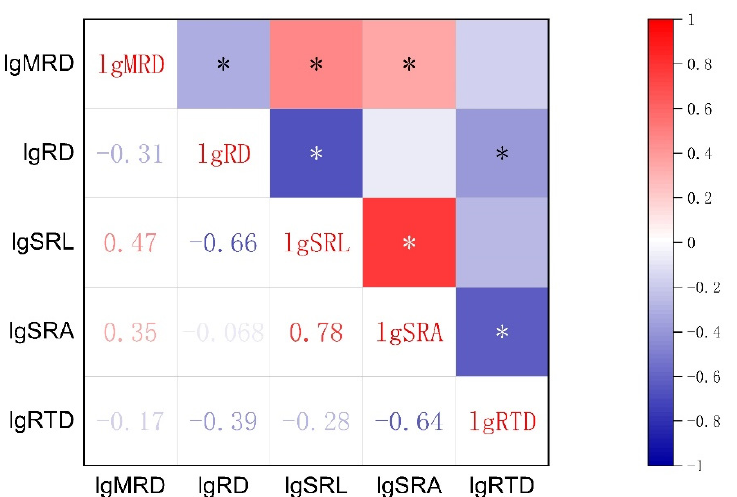
Figure 1. Correlation among the root traits of 50 ephemeral plants growing in two soil environments (loose sand or dense, gravelly sand) in the cold desert of the Chinese Junggar Basin in 2022. The color gradually changes from blue to red indicating that the inter-trait correlation changes from negative to positive correlation, with the darker color indicating the stronger the correlation. The values of each root trait were transformed by log10 to assume normality and homogeneity of variance. The meanings of MRD, RD, SRL, SRA, and RTD are maximum root depth, root diameter, specific root length, specific root area, and root tissue density, respectively. * indicates p < 0.05.